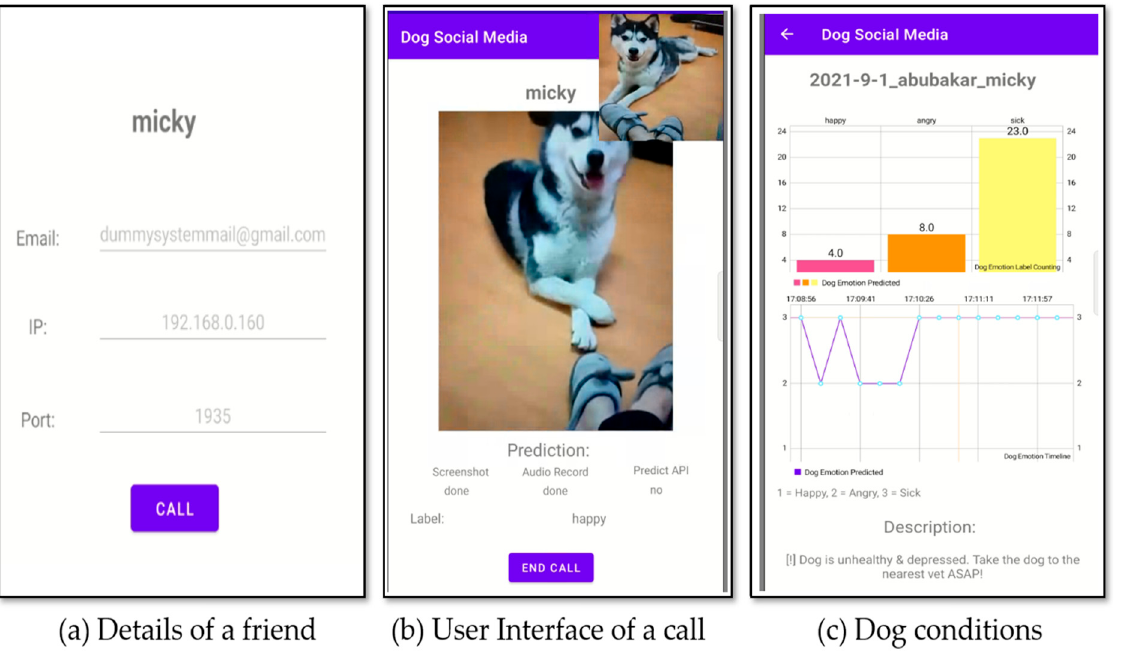
Figure 11. User interface to make a friend call and show the dog’s conditions: ( a ) contact a friend in the name list, ( b ) connect to a dog friend and live streaming, and ( c ) analysis report of the dog emotion.